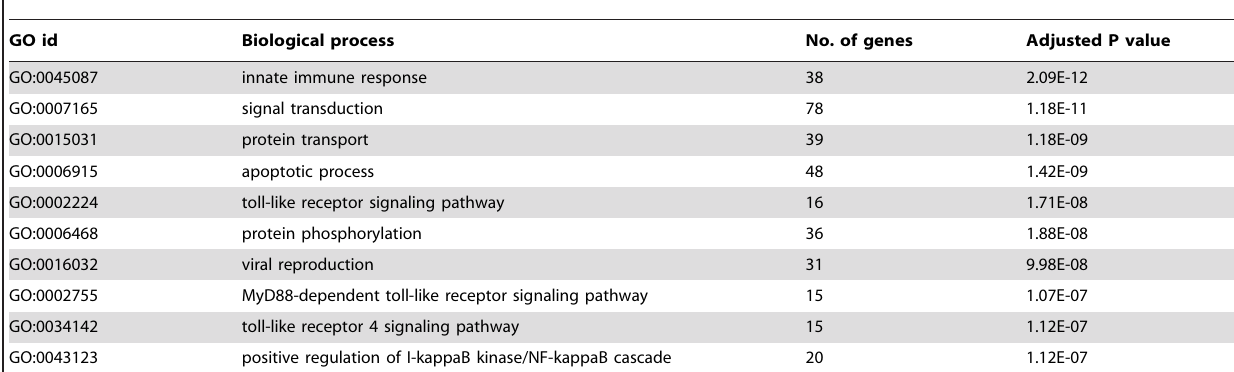
Table 3. The top ten biological processes enriched in the DEG list.